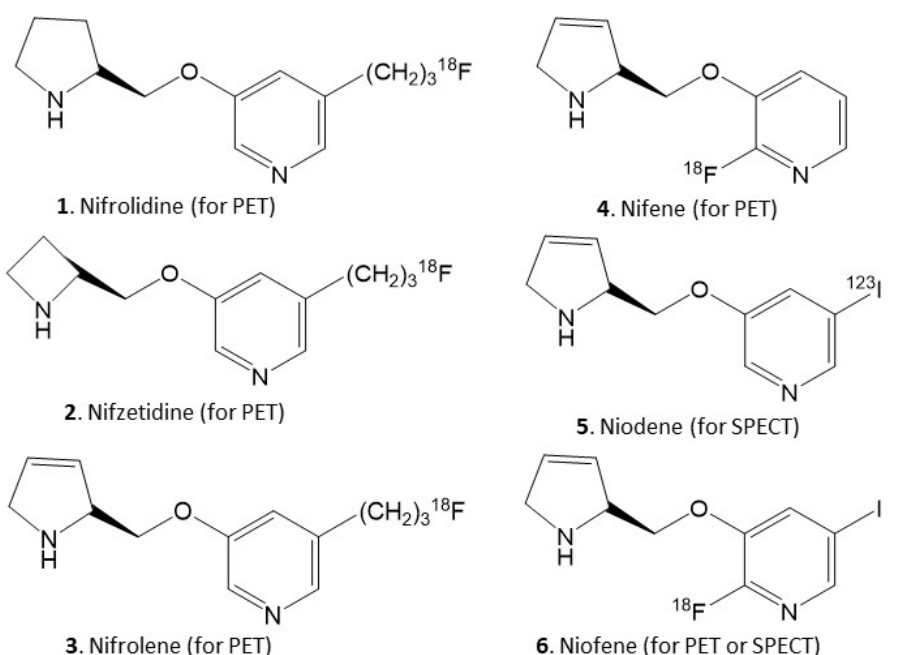
Figure 1. Chemical structures of PET and SPECT radiotracers for α 4 β 2* nAChRs. 1 . [ 18 F]Nifrolidine (PET); 2 . [ 18 F]nifzetidine (PET); 3 . [ 18 F]nifrolene (PET); 4 . [ 18 F]nifene (PET); 5 . [ 123 I]niodene (SPECT); 6 . [ 18 F] or [ 123 I]niofene (PET or SPECT).